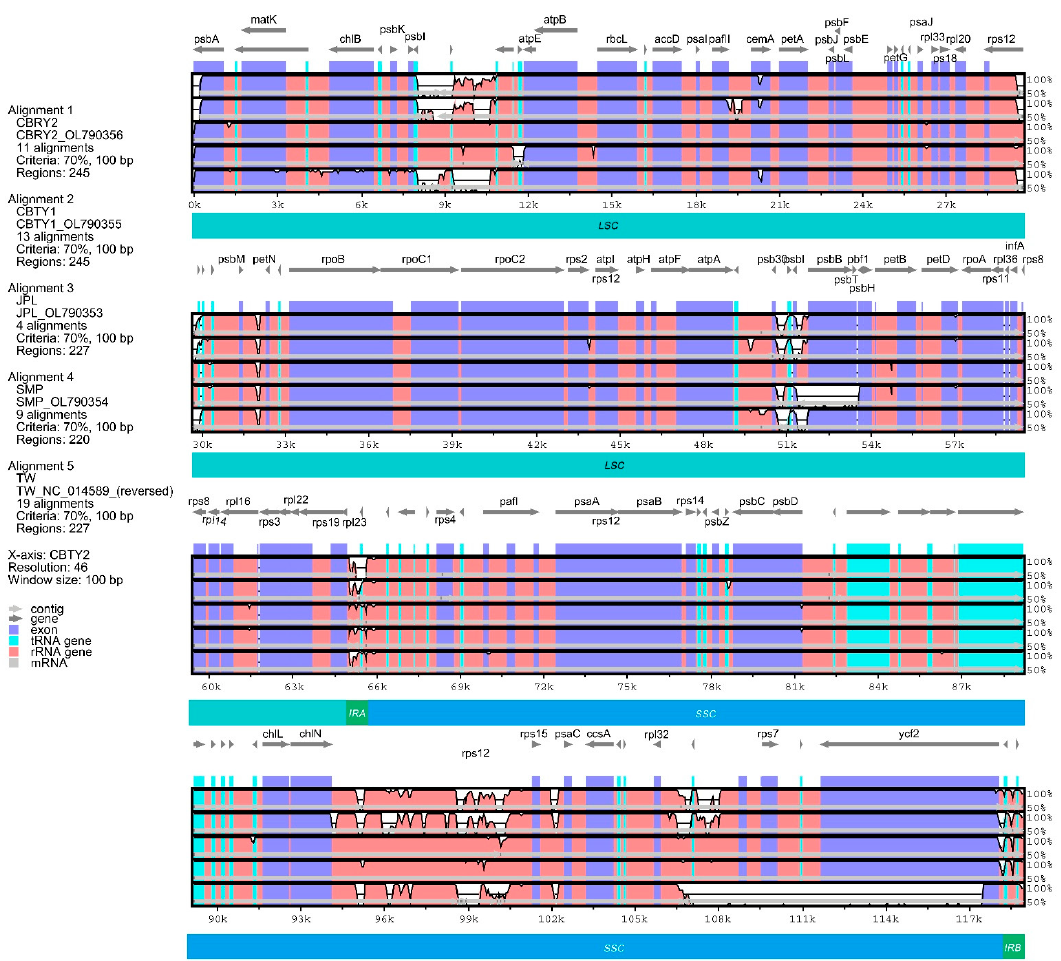
Figure 4. Comparative analysis of chloroplast genome sequence differences between Cathaya argyrophylla populations located at six different locations in China. The CBTY2 genome was used as the reference genome. Gray arrows and thick black lines above each alignment indicate gene orientation. The y -axis represents the percentage identity (50–100%). CBTY1, CBTY2 and CBRY2 were collected from Chengbu County of Hunan Province. JPL and SMP were collected from Chengzhou City of Hunan Province. TW was collected from Taipei City of Taiwan Province in a previously published study.